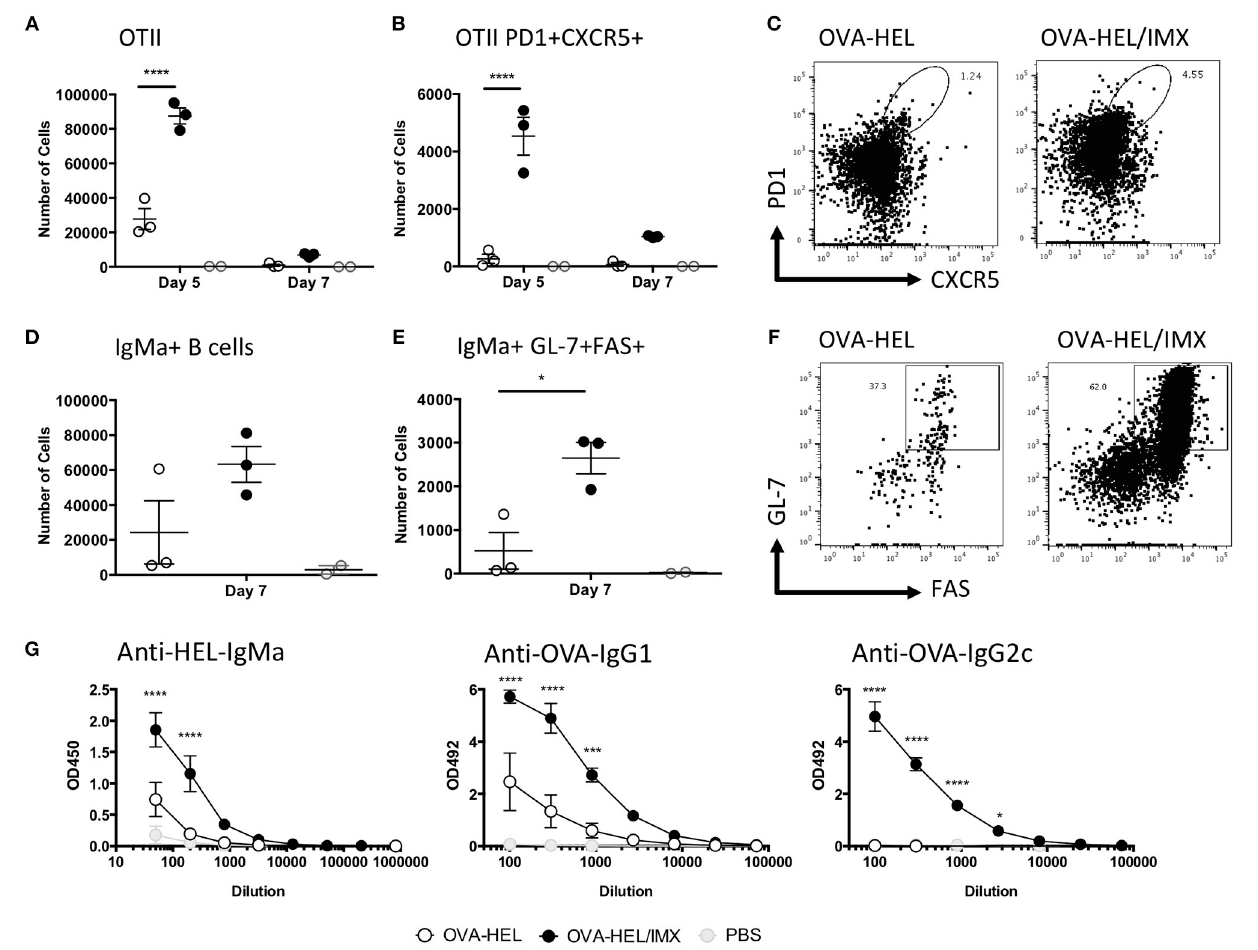
FIGURE 7 | ISCOMATRIX stimulates Tfh and germinal center B cell responses. (A) Total number of OVA specific (OTII) CD4 + T cells in the lymph node, and (B) the number are CXCR5 + PD1 + at 5 and 7 days. (C) Representative flow cytometry plots showing CXCR5 and PD1 staining on OTII CD4 + T cells from OVA-HEL and OVA-HEL/ISCOMATRIX treated mice at 5 days. (D) Total number of HEL specific (MD4) B cells and (E) the number that are GL-7 + /FAS + at 7 days. (F) Representative flow cytometry plots showing GL-7 and FAS staining on MD4 B cells from OVA-HEL and OVA-HEL/ISCOMATRIX treated mice at 7 days. (G) Graphs showing the mean ± SEM serum anti-HEL IgMa, anti-OVA IgG1, and anti-OVA IgG2c titers at 14 days post-immunization with OVA-HEL, OVA-HEL/ISCOMATRIX or PBS. Immunized groups contained 3 animals and are representative of 2 independent experiments. IMX = ISCOMATRIX TM adjuvant, * P < 0.05, *** P < 0.001, **** P <